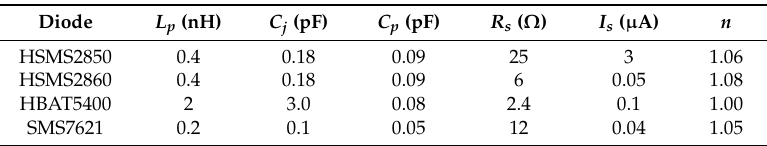
Table 2. The parameters of Schottky